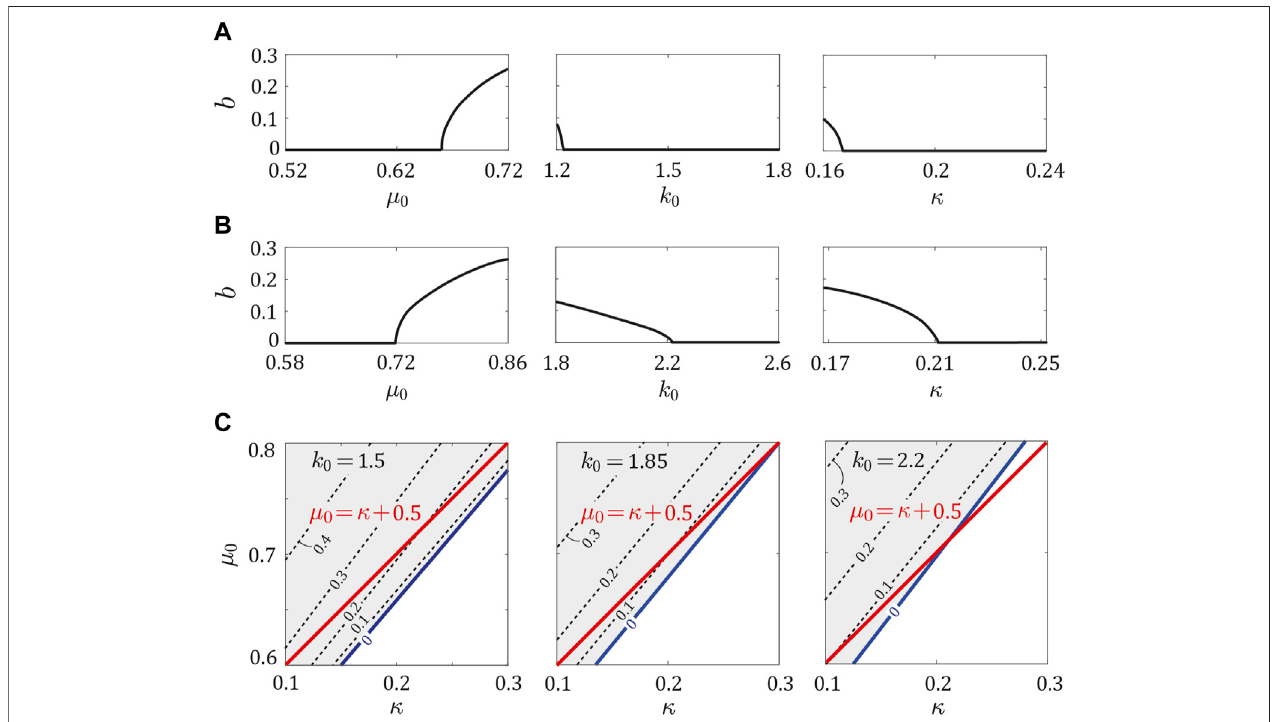
FIGURE 6 | Dependence of b on μ 0 , k 0 , and, κ . b vs., μ 0 , k 0 , and, κ using the parameter sets for (A) dogs and (B) horses, while holding the other parameters constantat( μ 0 , k 0 , κ )=(0.62,1.5,0.2)fordogsand(0.72,2.2,0.21)forhorses. (C) Contourof b around μ 0 = κ +0.5for k 0 =1.5,1.85,and2.2.Redandbluelinesindicate μ κ + 0.5 and boundary of b = 0 and b > 0, respectively. White and gray regions indicate b = 0 and b > 0, 0 =